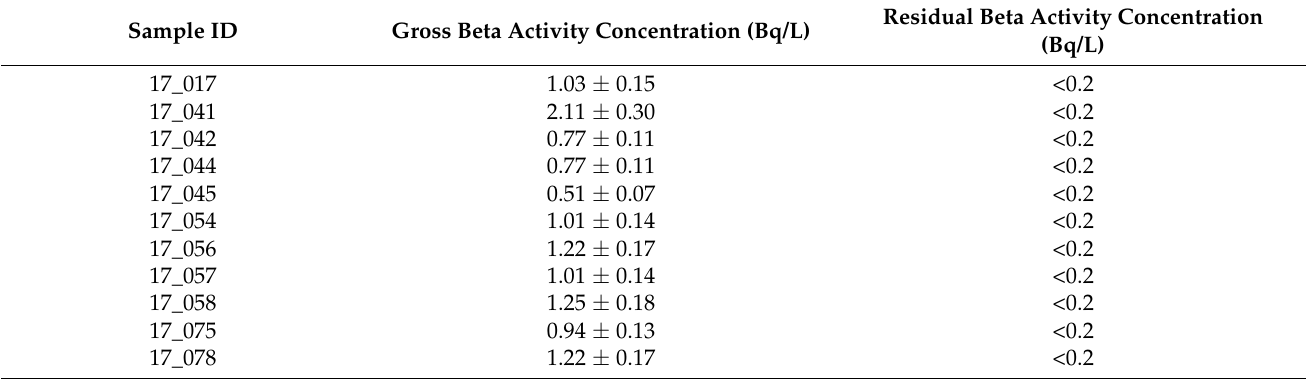
Table 6. Gross beta activity concentration of 16 samples and the calculated residual beta activity